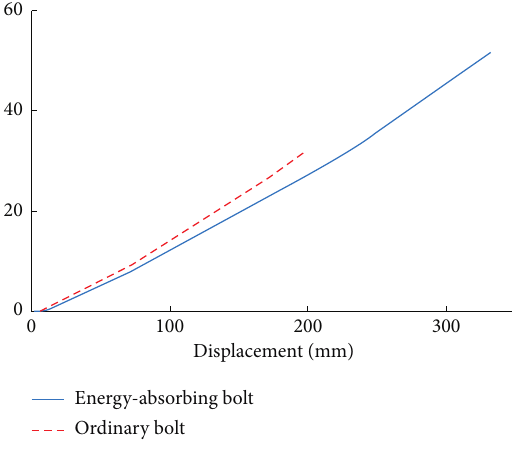
Figure 12: Energy absorption